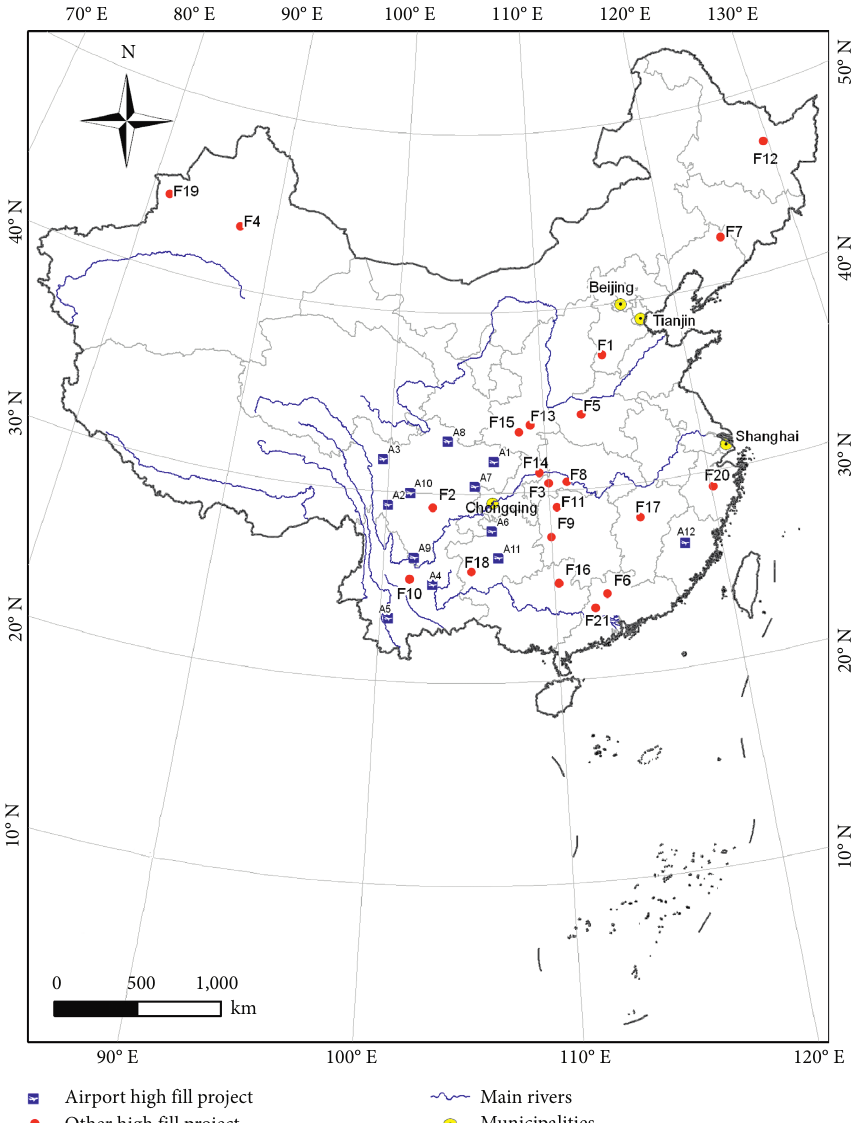
Figure 1: Distribution of several high fill airport projects and several other high fill projects in